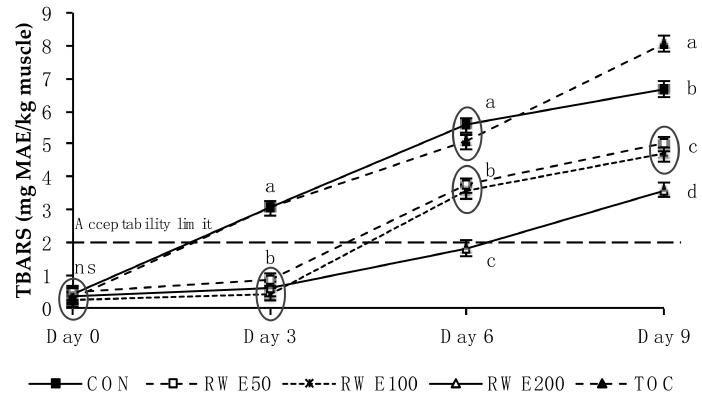
Figure 1. Lipid oxidation (TBARS) measured in n -3-enriched lamb meat patties over the 9-day storage period in high oxygen modified atmosphere packs (HiOx-MAP), containing different levels of antioxidants. CON: control without antioxidant; RWE50: 50 mg GAE/kg muscle; RWE100: 100 mg GAE/kg muscle; RWE200: 200 mg GAE/kg muscle; TOC: 100 mg -tocopherol/kg muscle. Data are expressed as mean value ± standard error of three replicates in duplicate. Different letters (a–d) mean significant differences among treatments ( p ≤